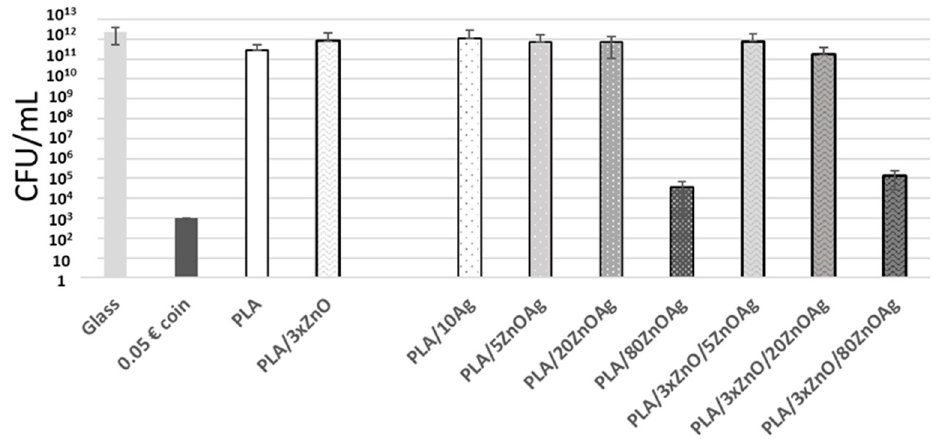
Figure 4. Surviving S. aureus (in CFU/mL) after 24 h contact with different surfaces: glass (light grey column), 0.05 Euro coin (dark grey column), PLA (white column), eventually including a 10 nm plasma Ag layer (PLA/10Ag), (white column with low amount of dots) or PLA/ZnO monolayer including 5 nm (light grey column with low amount of dots), 20 nm (light grey column with medium amount of dots), 80 nm (dark grey column with high amount of dots) ZnOAg (PLA/5ZnOAg, PLA/20ZnOAg, PLA/80ZnOAg) and PLA/ZnO trilayer 1% (white column with “waves”), eventually including 5 nm (light grey column with waves), 20 nm (grey column with waves) or 80 nm (dark grey column with waves) plasma ZnOAg layer (PLA/3xZnO/5ZnOAg, PLA/3xZnO/20ZnOAg, PLA/3xZnO/80ZnOAg). Tests were carried out three times per